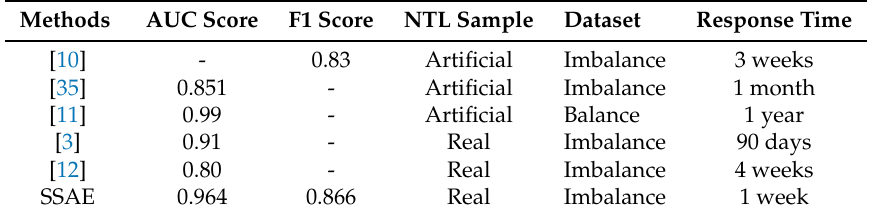
Table 5. Comparison with the